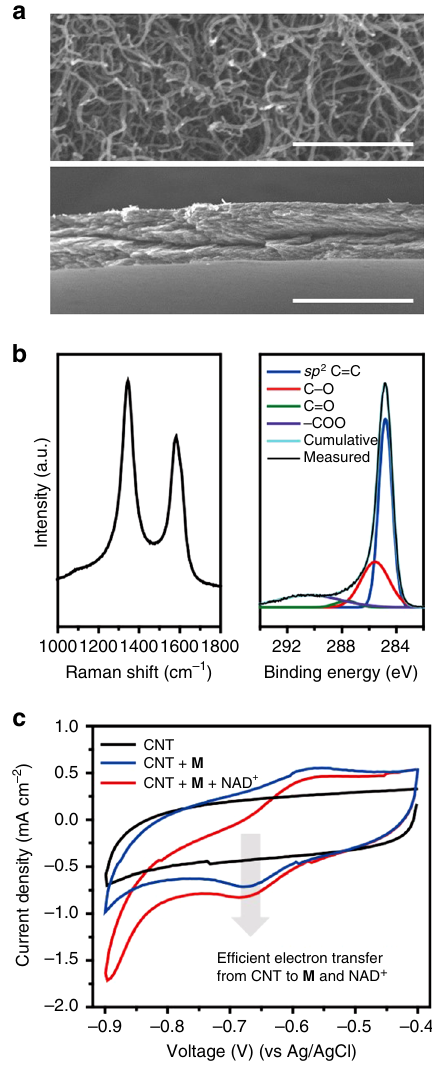
Fig. 4 Characterization of CNT fi lm cathode. a SEM images of CNT fi lm in top view (upper image, sclae bar: 500 nm) and cross-section (lower image, scale bar: 100 μ m). b Raman spectrum (left) and XPS local scan spectrum of C1 s region (right) of CNT fi lm. c The changes of the cyclic voltammogram of CNT fi lm (black) by the addition of M (blue) and NAD + (red). Experimental conditions: 0.5 mM M , 1 mM NAD + in a phosphate buffer (0.1 M, pH 7.5), scan rate: 5 mV s −